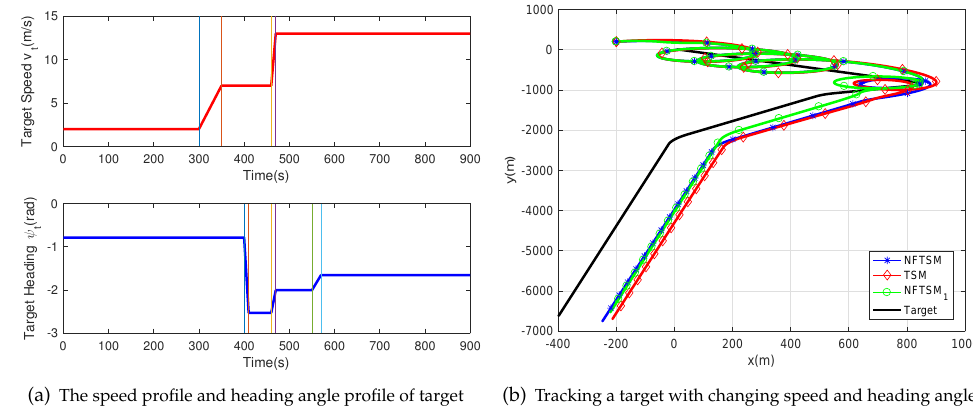
Figure 9. The trajectory of the moving target and the UAV.